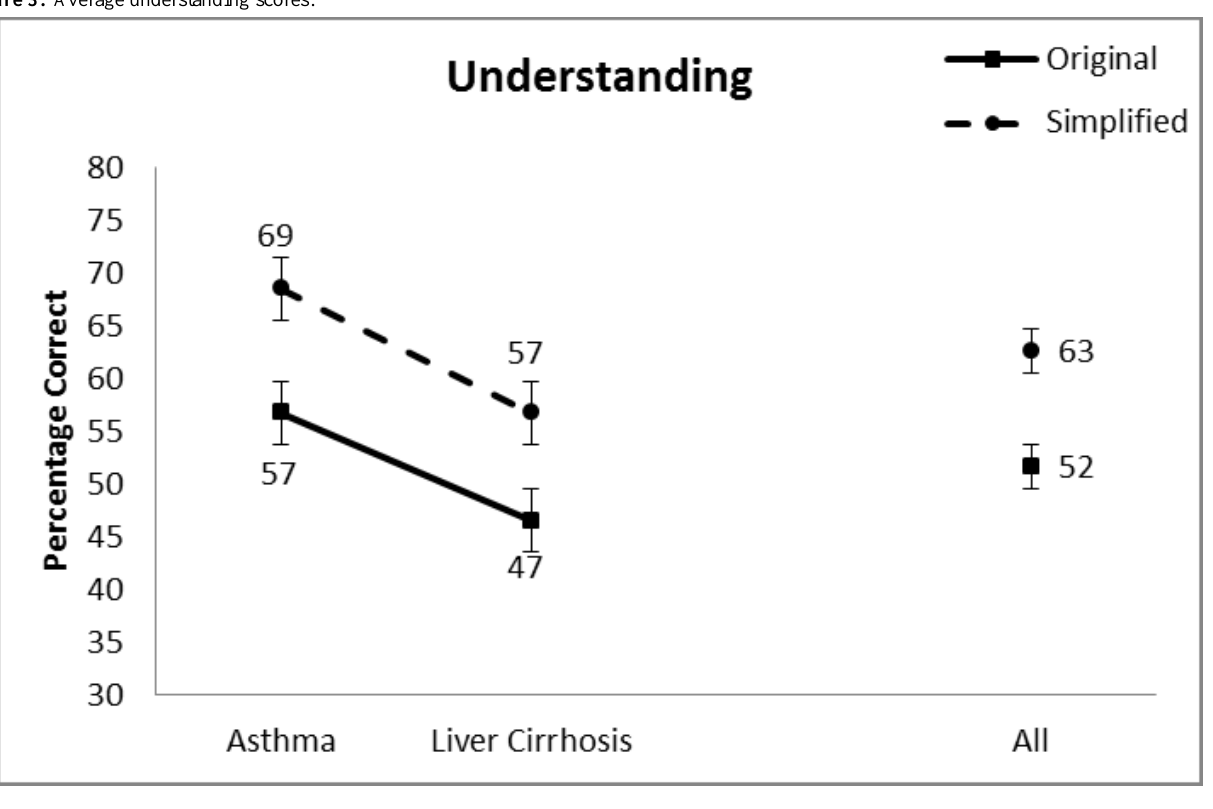
Figure 3. Average understanding